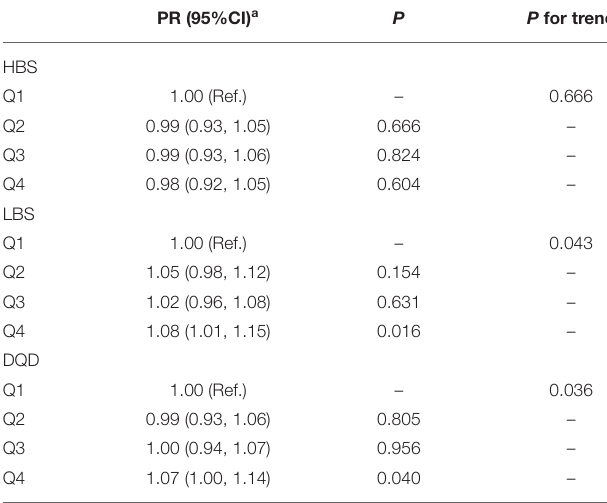
TABLE 3 | Comparison of HBS, LBS, and DQD [Median (25 th , 75 th )] by depression status.